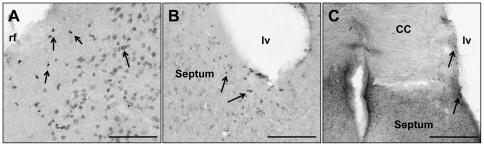
GFP+ cells found in areas outside of the hippocampus.A. Half of trisomic mice had GFP+ cells in the entorhinal cortex (arrows). B. GFP+ cells were found near the lateral ventricles in the septum (arrows). C. GFP+ mNPC also were found in the CC and again in the underlying septal areas (arrows). rf, rhinal fissure; lv, lateral ventricles; CC, corpus callosum. Scale Bars in A = 100 µm and in B–C = 200 µm.